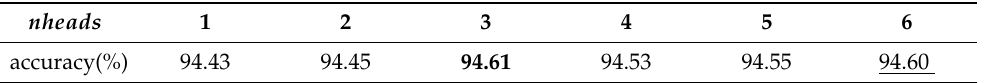
Table 1. The validation accuracy comparisons of models using GAB with different numbers of heads.